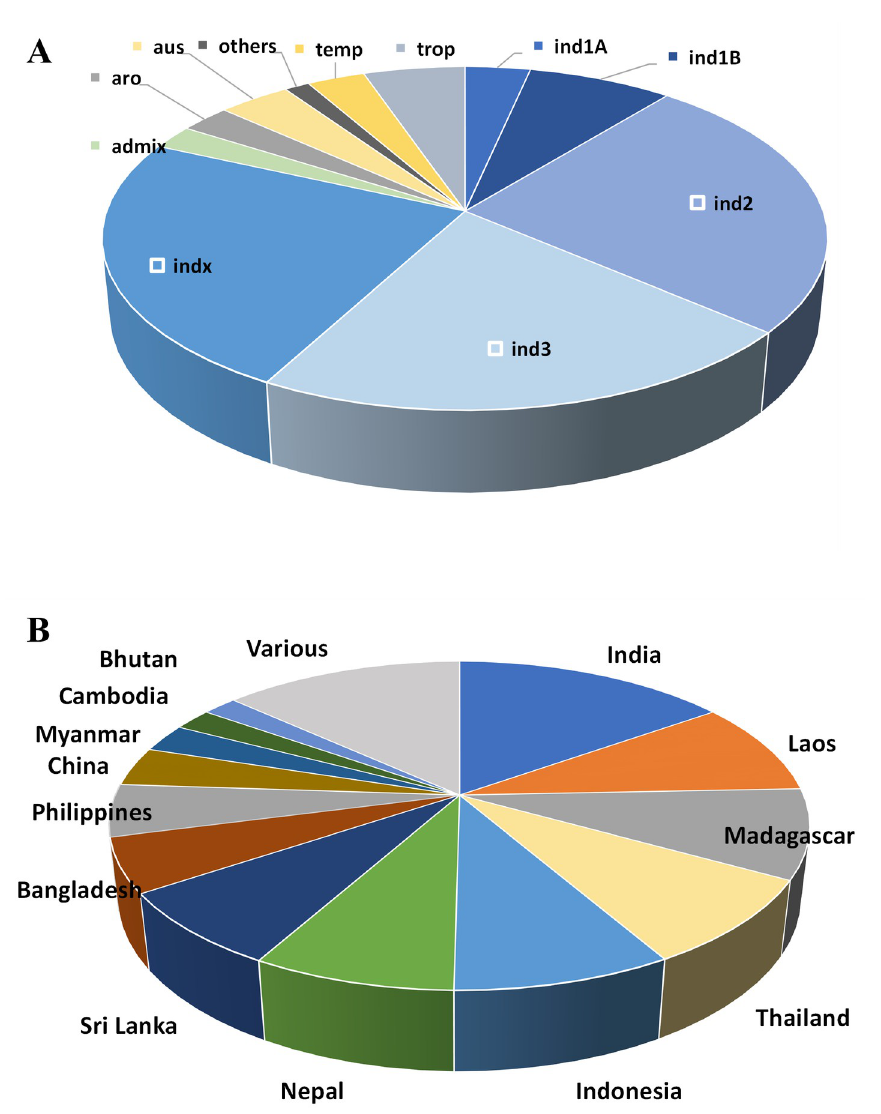
Fig 1. Distribution of subspecies (A) and country of origin (B) of selected rice accessions in the GWAS panel. aro: aromatic; aus: aus; ind: indica; trop: tropical; temp: temperate; admix: admixture.